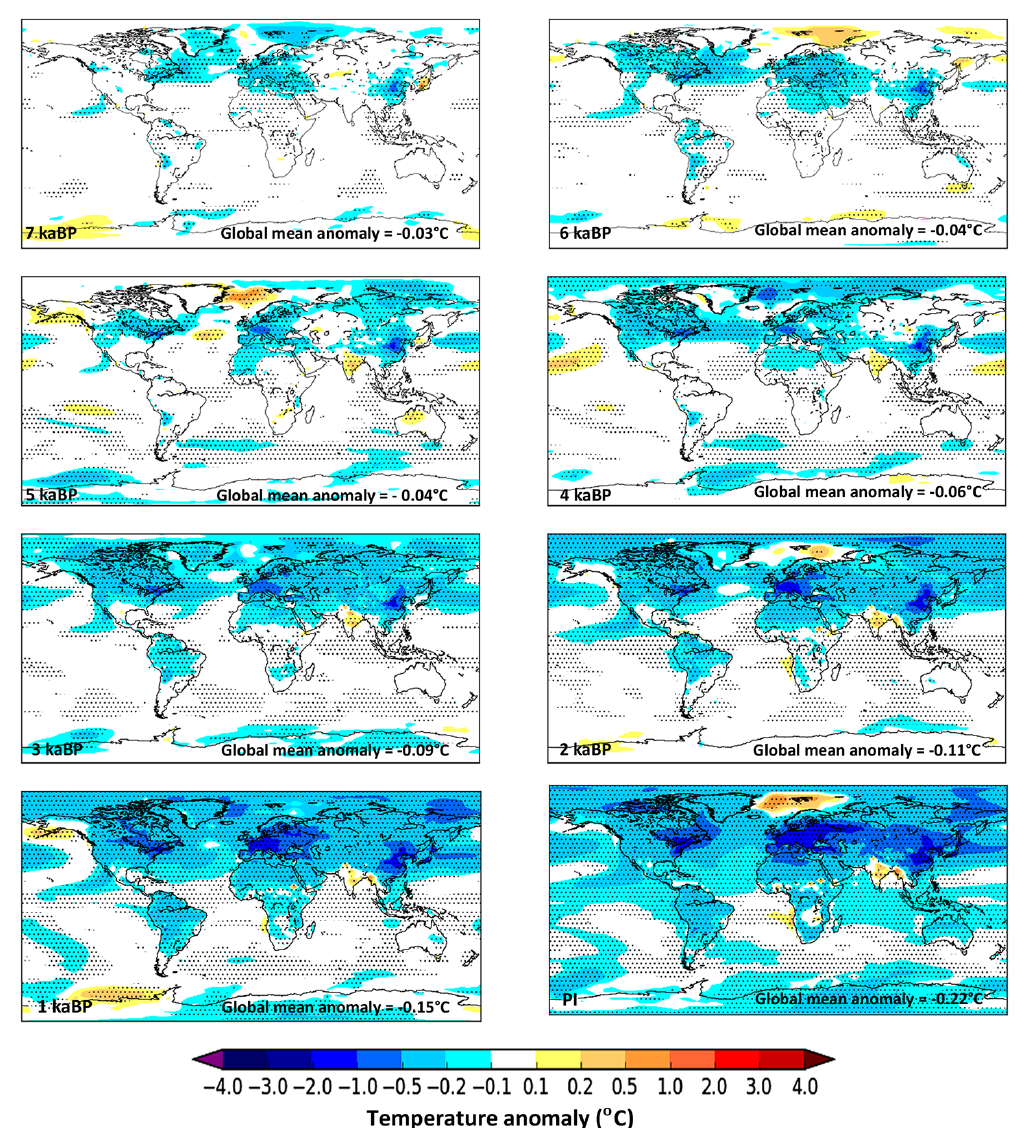
Figure 4. Annual temperature anomalies ( ◦ C) for KK10 minus control at time slices from the late pre-industrial period (1850CE) to 7kaBP. The stippling indicates grid boxes where the anomalies are significant at the 95% level using Wilcoxon rank sum statistical